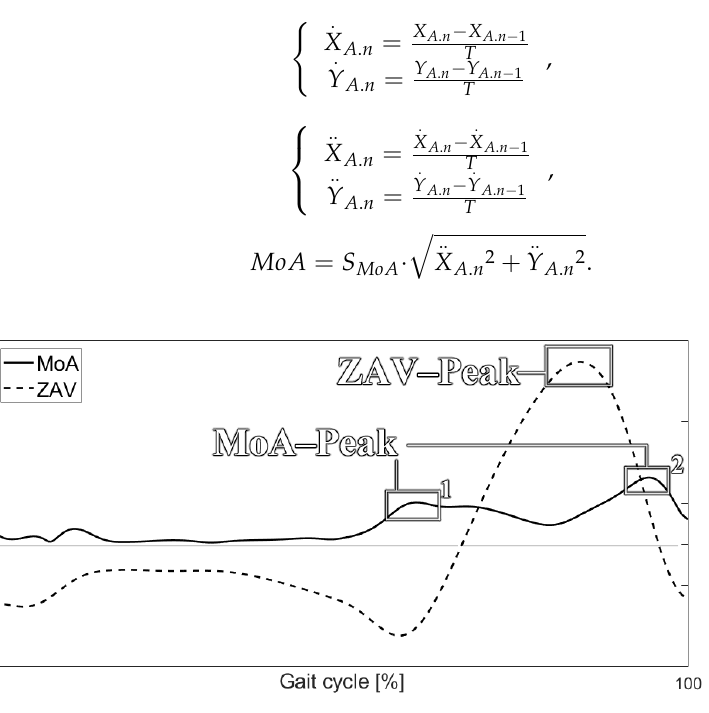
Figure 2. Sample of the converted MoA and ZAV.